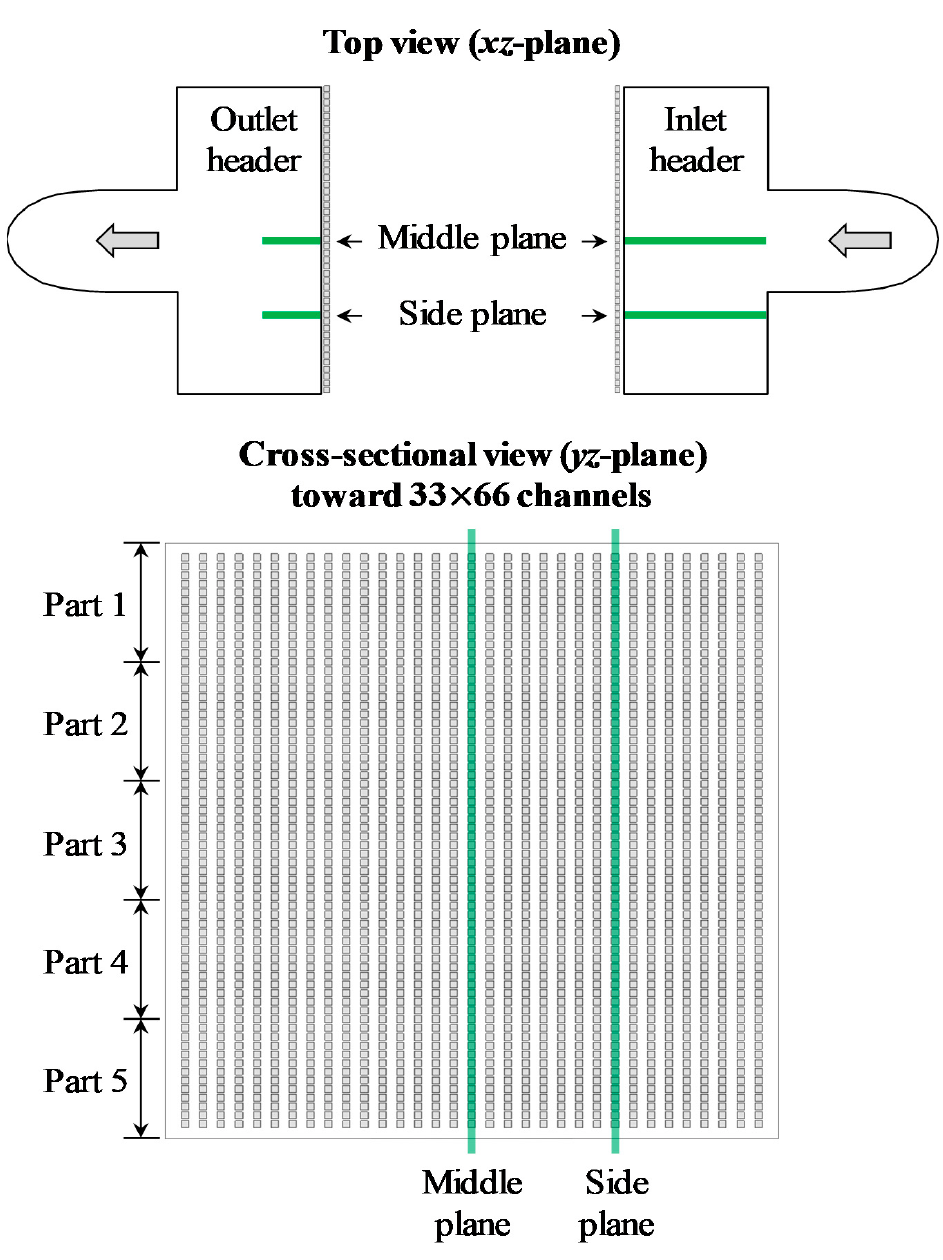
Figure 12. Positions of laser sheets for planar PIV.